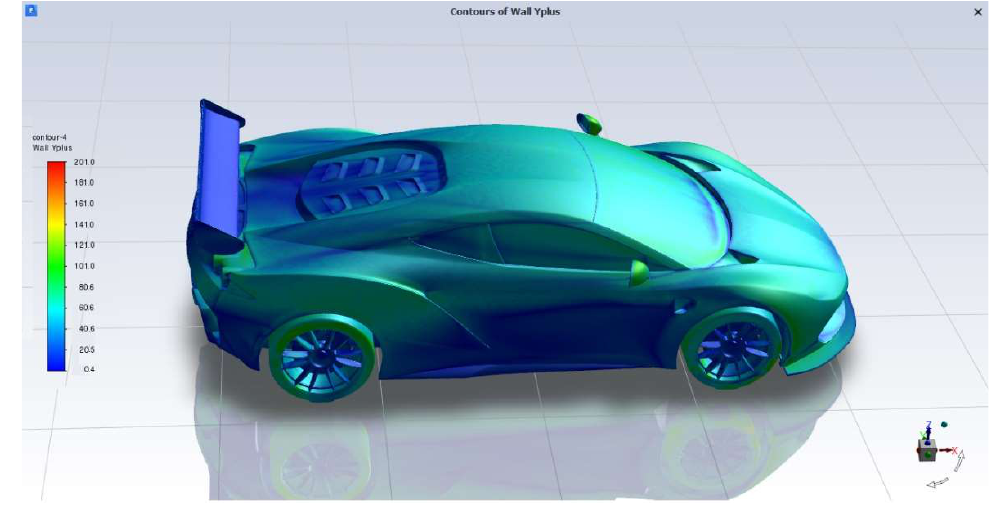
Figure 6. Exemplary y+ distribution.